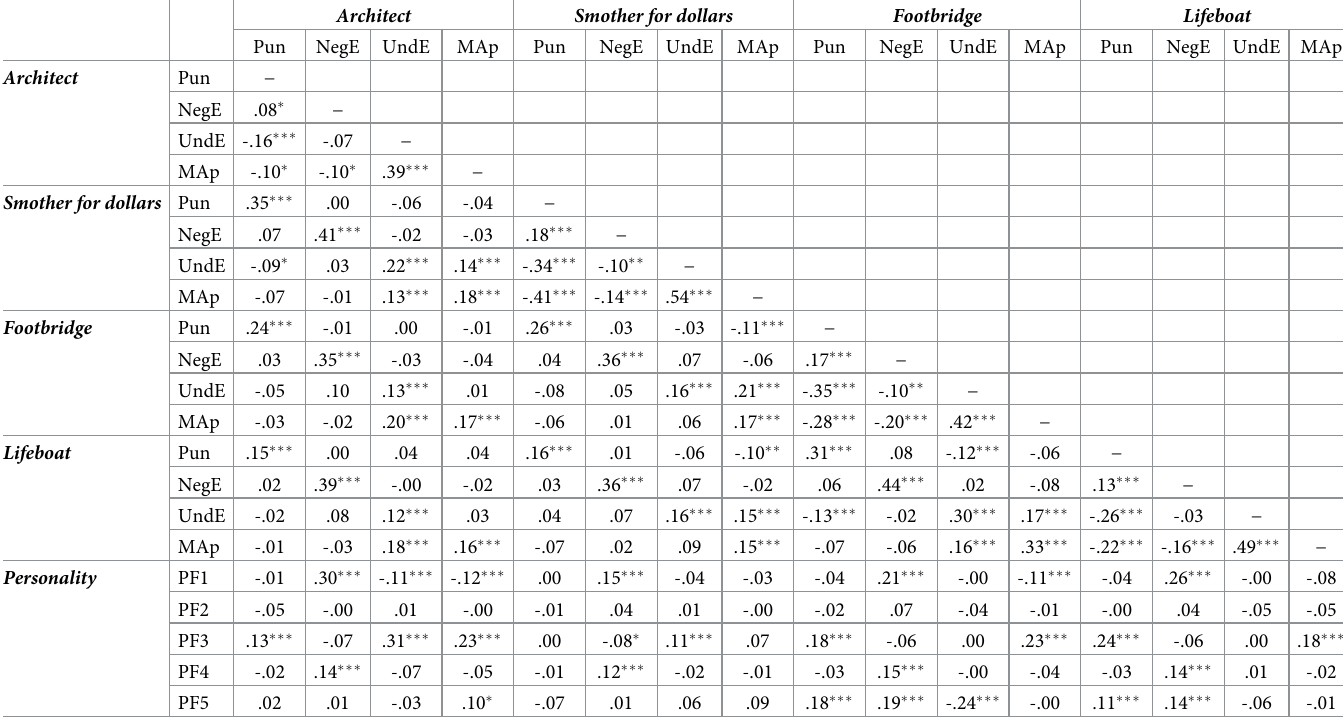
Table 3. Correlations of experimental outcomes and personality domains ( N =